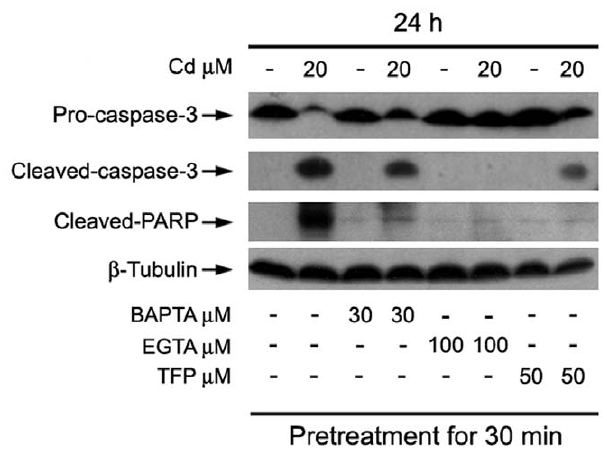
Figure 8. Cd-elevated [Ca 2 + ] i induces ROS, triggering apoptosis of neuronal cells. PC12 cells, pretreated with/without BAPTA/AM, EGTA, and TFP at indicated concentrations for 30 min, were treated with/without 20 m M Cd for 24 h, followed by Western blot analysis using indicated antibodies. The blots were probed for b -tubulin as a loading control. Similar results were observed in at least three independent experiments.